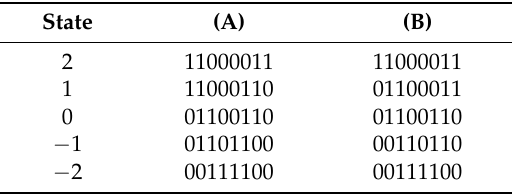
Table 3. The two pulse mappings of the five-level NPC/H-Bridge inverter.